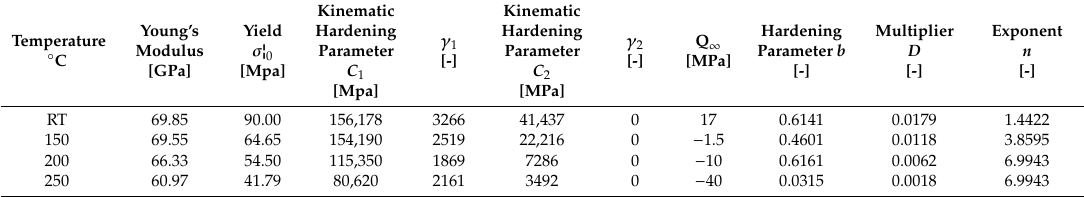
Table 4. Visco-plastic model parameters of the Chaboche + Cowper–Symonds rate-dependent model. Temperature ◦